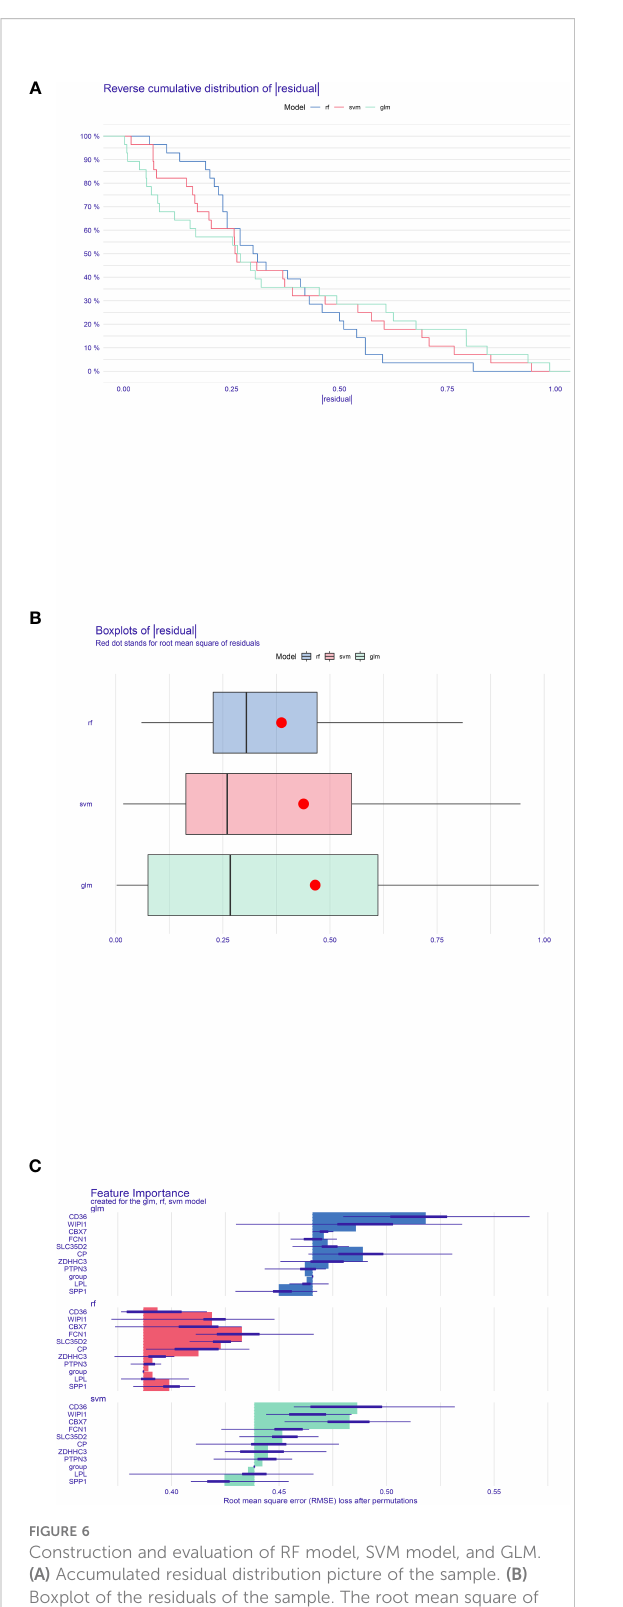
FIGURE 6 Construction and evaluation of RF model, SVM model, and GLM. (A) Accumulated residual distribution picture of the sample. (B) Boxplot of the residuals of the sample. The root mean square of the residuals was indicated by a red dot. (C) The signi fi cance of the variables in the three models.